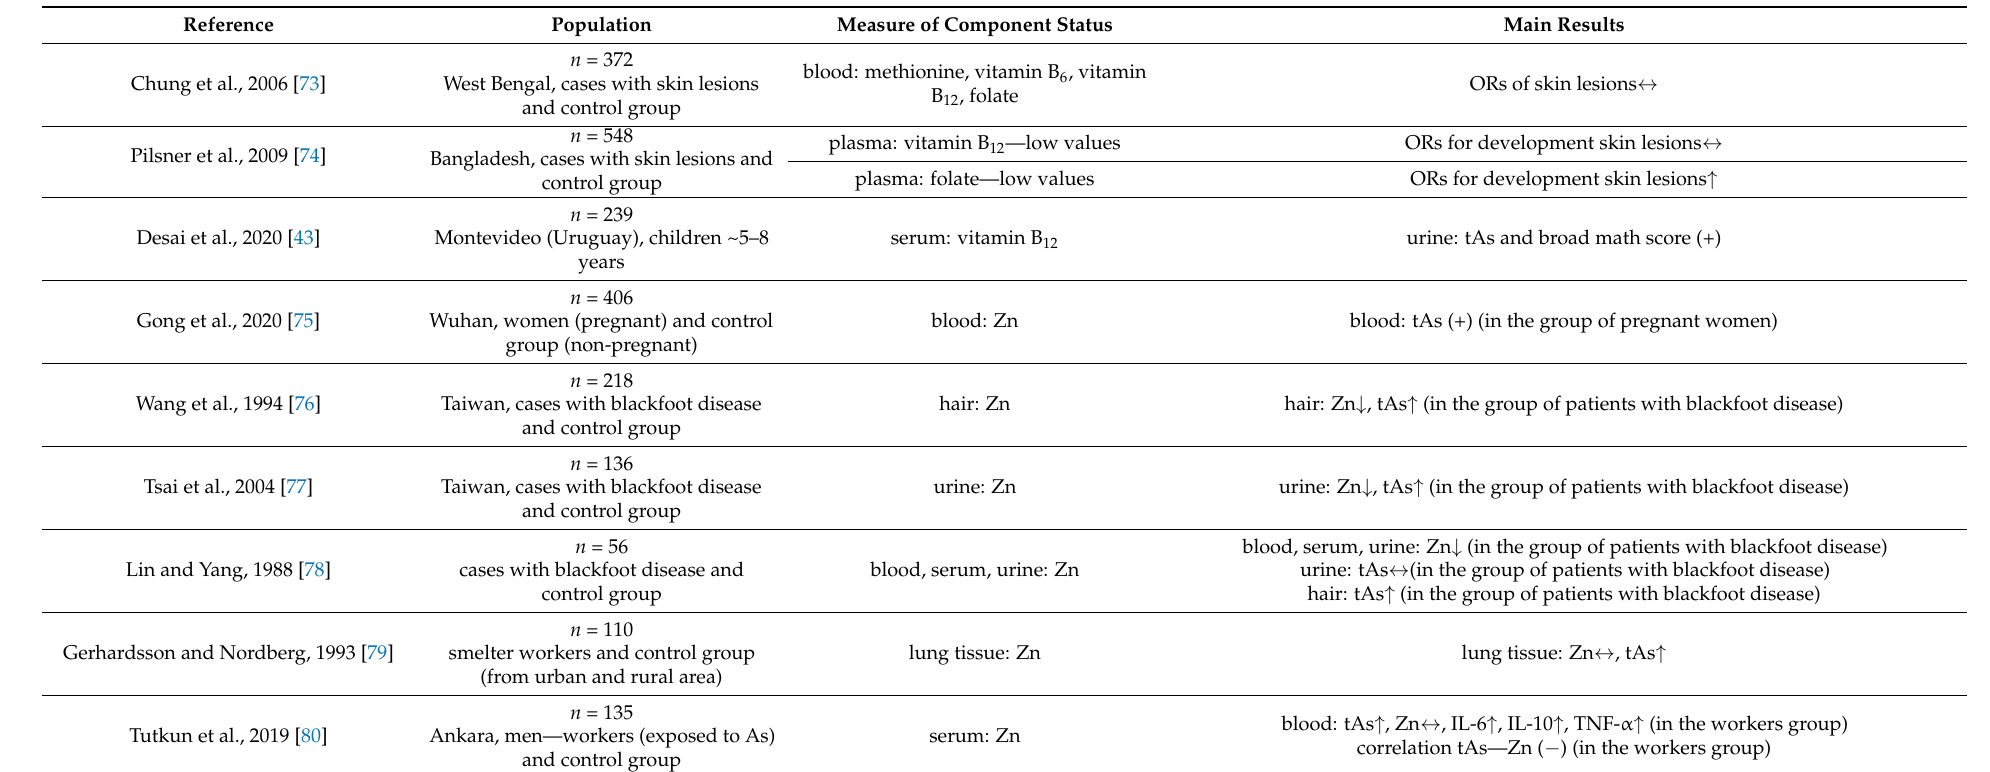
urine: Zn urine: Zn ↓ , tAs ↑ (in the group of patients with blackfoot disease) blood, serum, urine: Zn ↓ (in the group of patients with blackfoot disease) urine: tAs ↔ (in the group of patients with blackfoot disease) hair: tAs ↑ (in the group of patients with blackfoot